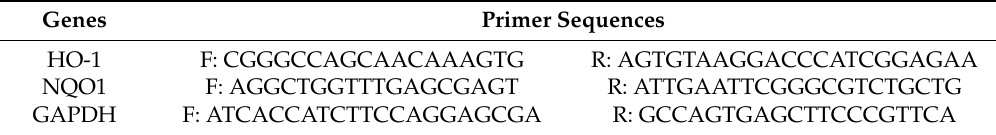
Table 1. List of mouse primer used for real-time reverse transcription-polymerase chain reaction (RT–PCR). Genes Primer